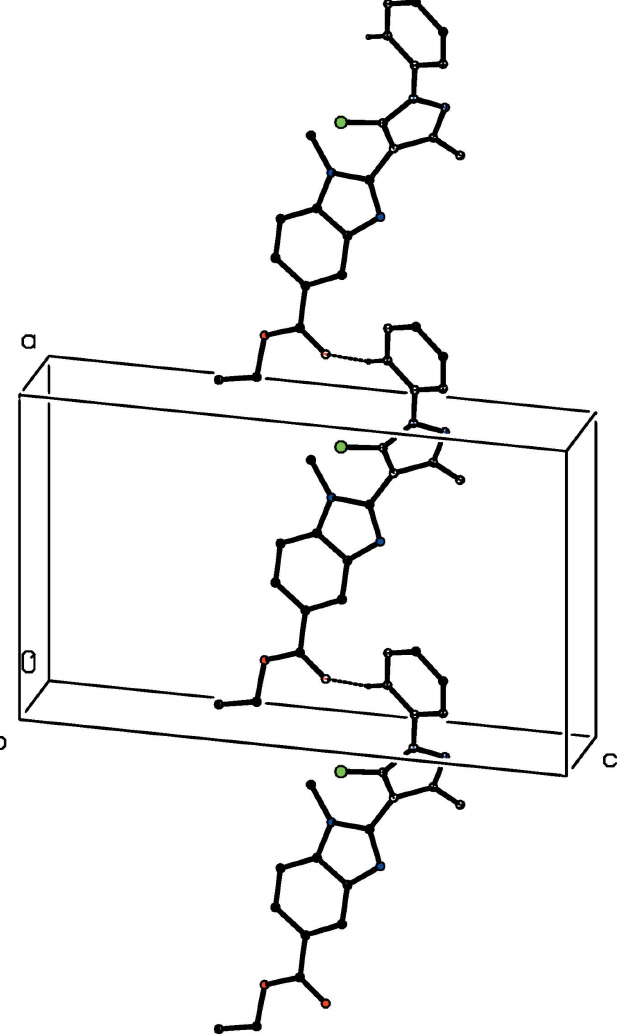
Figure 7 Part of the crystal structure of compound (III) showing the formation of a hydrogen-bonded C (13) chain parallel to [100]. Hydrogen bonds are drawn as dashed lines and, for the sake of clarity, the H atoms not involved in the motif shown have been omitted.